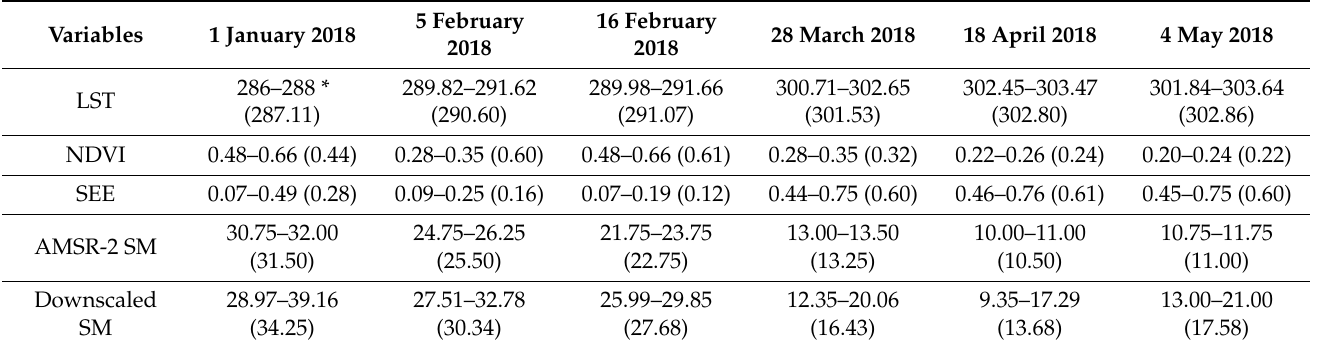
Table 2. Descriptive statistics of LST, NDVI, SEE, AMSR-2, and Downscaled soil moisture for the selected six days. * The values in brackets represent the median value of the spatial